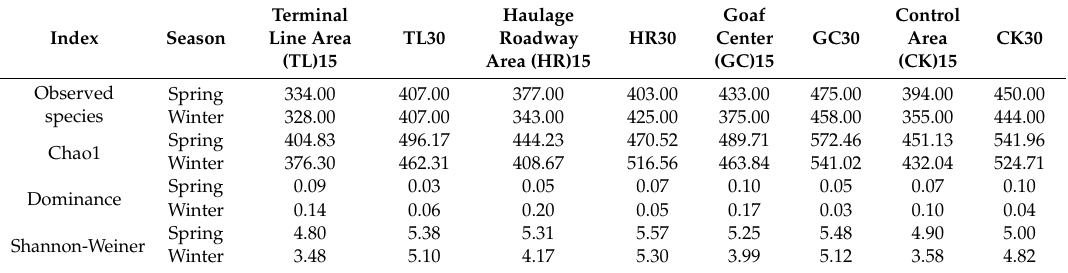
Table 2. Mean alpha diversity index values for Arbuscular Mycorrhizal AMF communities.